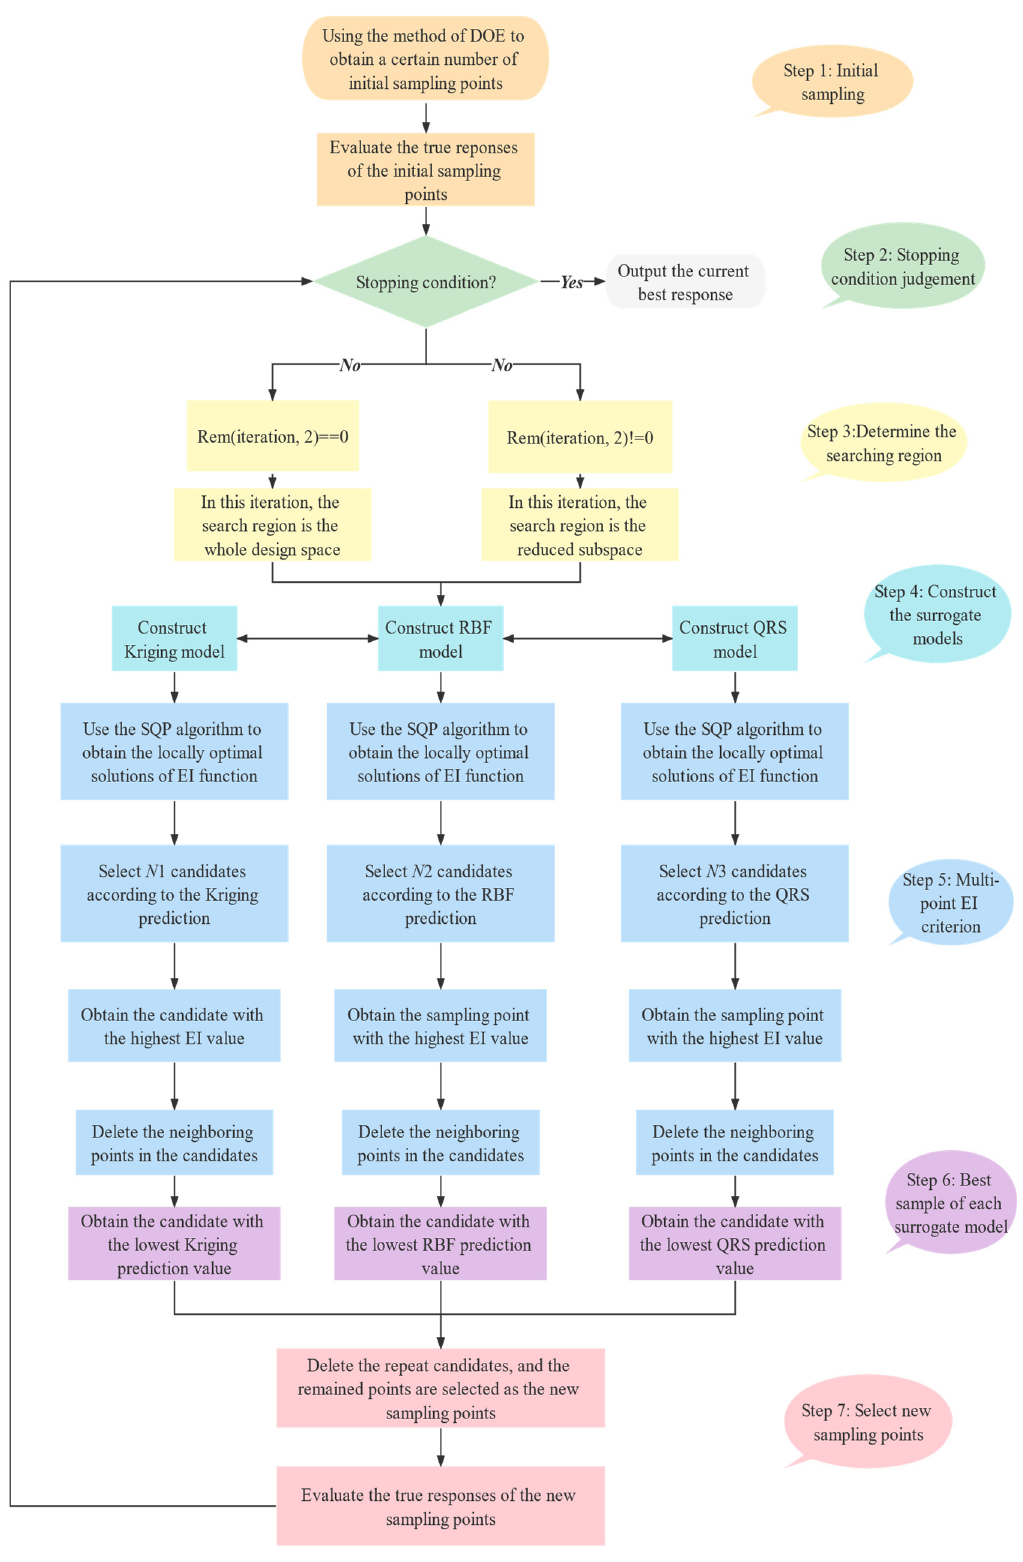
Figure 2. Flowchart of the MSMEIC algorithm.